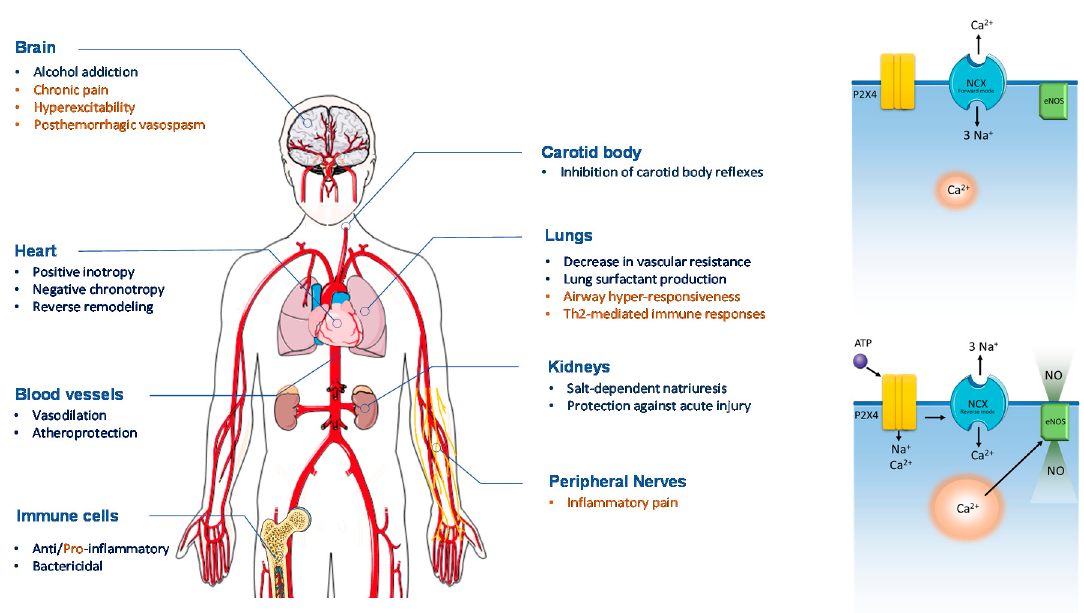
Figure 1. Schematic overview of systemic P2X4R stimulation. An overall cardioprotective effect is observed with P2X4R stimulation. Permeation of Na + and Ca 2+ ions through P2X4R interferes with the forward mode of the Na + -Ca 2+ exchanger (NCX) and Ca 2+ -dependent activation of endothelial nitric oxide synthase (eNOS) (right panels). In the heart, stimulation of P2X4R improves cardiac muscle contraction and optimizes myocardial energy supply vs. demand by reducing chronotropy. The diuretic effect of P2X4R activation together with its vasodilation properties in both systemic and pulmonary arteries optimizes preload and afterload and, thereby, cardiac output in HF. Chronic activation of the P2X4R reverses maladaptive cardiac remodeling and improves the outcome of HF. Future P2X4R agonist therapies must deal with the wide P2X4R distribution throughout the human body resulting in putative unwanted side-effects (marked in orange). Figure composition used elements from Servier Medical Art (https://smart.servier.com).